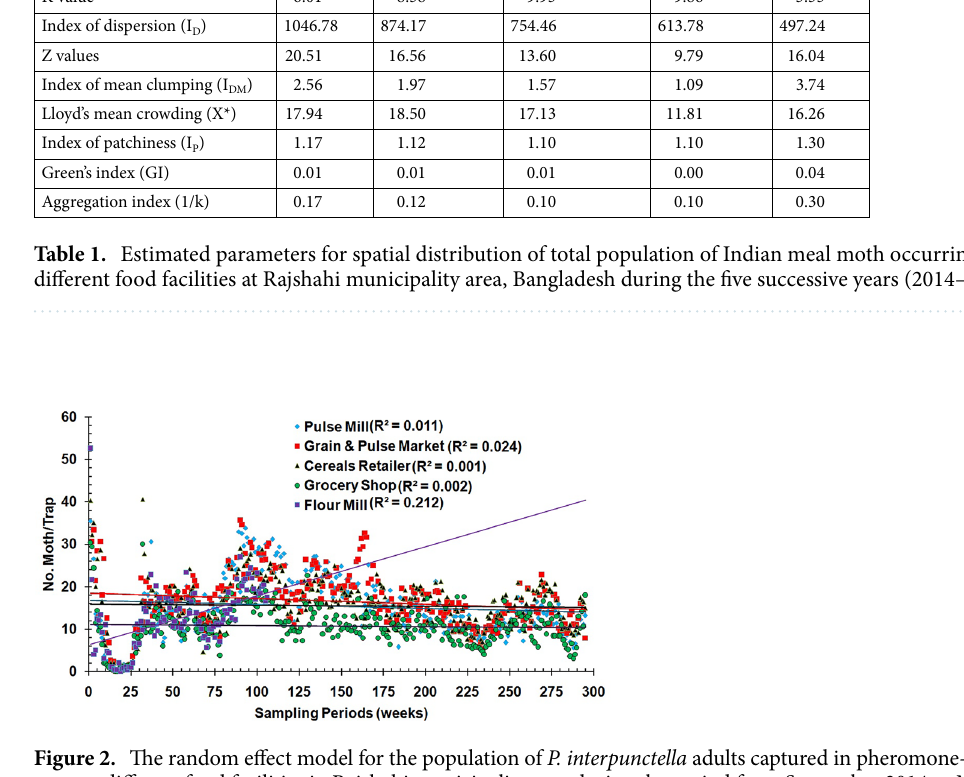
Figure 2. The random effect model for the population of P. interpunctella adults captured in pheromone-baited traps at different food facilities in Rajshahi municipality area during the period from September 2014 to March